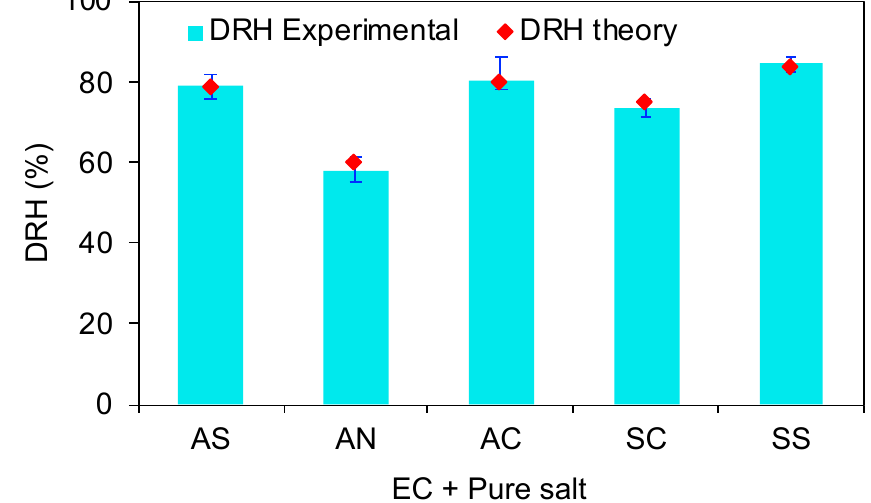
Figure 6. Theoretical and measured DRH for ammonium sulfate (AS), ammonium nitrate (AN), ammonium chloride (AC), sodium chloride (SC), sodium sulfate (SS) mixed with laboratory generated EC.